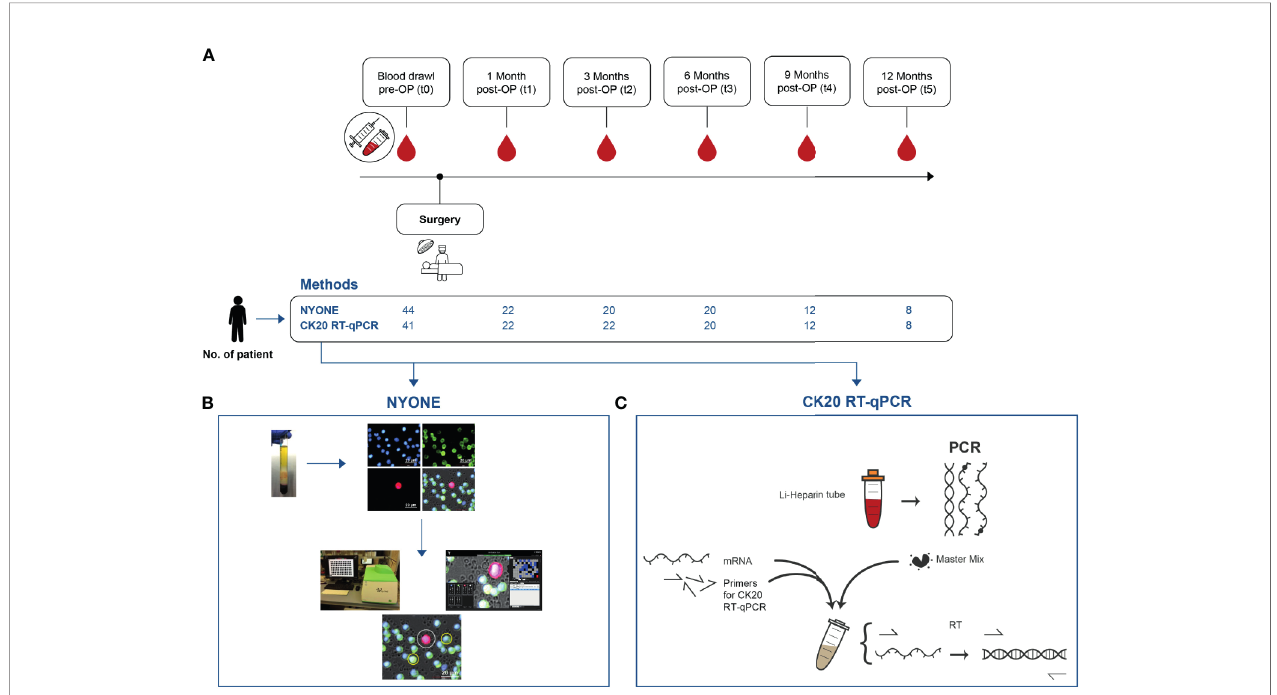
FIGURE 1 | Study outline and synopsis of the employed techniques for CTC detection. (A) Blood samples were collected repeatedly over a course of 12 months post-operatively. The fi rst blood sample of each recruited patient was drawn immediately pre-operatively t0. Over the study period, fi ve more samples were collected at set follow-up visits of each patient at 4 weeks (t1), 3 months (t2), 6 months (t3), 9 months (t4), and 12 months (t5). (B) NYONE ® – After CTC enrichment by Ficoll centrifugation via CPT tubes, PBMC were fi xed, permeabilized, and stained with anti-CD45-Alexa488 (green to detect leukocytes), anti-EpCAM, anti-EGFR, anti- Her2, and anti-pan-CK antibodies (all Alexa647-coupled, red to detect epithelial cells) and DAPI (blue) for nuclei staining. The enumeration process of CTC was carried out by the cell imager NYONE ® . After image analysis, CTC (DAPI positive, negative for Alexa488, and positive for Alexa647) were encircled allowing cytological assessment. (C) Semi-quantitative RT-qPCR against CK20 – After Ficoll centrifugation of the blood plasma samples, the enriched fraction of PBMC was isolated and cDNA was obtained after RNA preparation. Then, a TaqMan gene expression assay [KRT20 (CK20)] and TBP as a house-keeping gene were